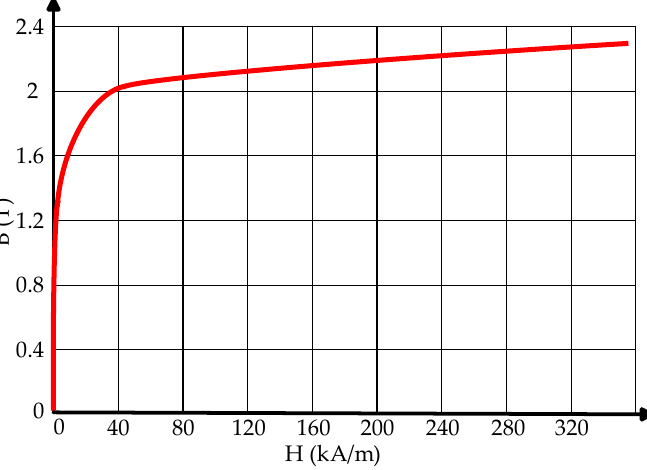
Figure 9. B – H curve of 1010 steel material. Vectorial magnetic flux density variation of the CDCLM, i.e., the direction of the magnetic flux, is given in Figure 10. In permanent magnets, the magnetic flux direction is from the N pole to the S pole. As shown in Figure 5, magnetic field lines in permanent magnets are in the r-direction. Thus, the magnetic field lines formed in the r-direction complete their path along the z-axis through the core and yokes. The highest magnetic flux density is shown in red and measured as 2.13 T in the core.